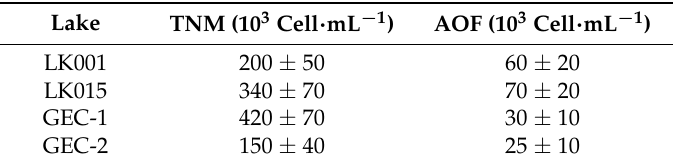
Table 3. The total number of micro-organisms (TNM) and number of autofluorescent cells (AOF) in the bottom water of Yamal lakes in April